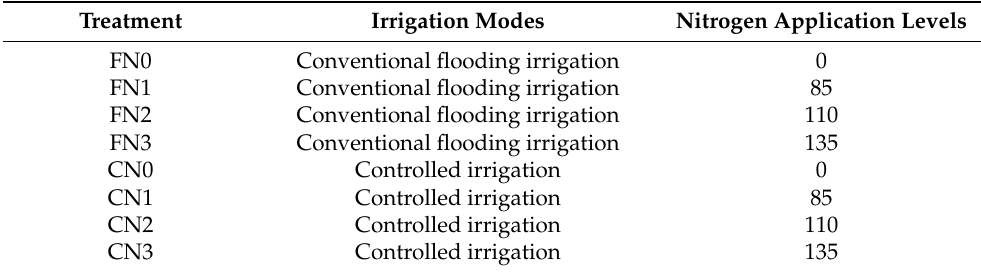
Table 1. Design of the experimental treatments